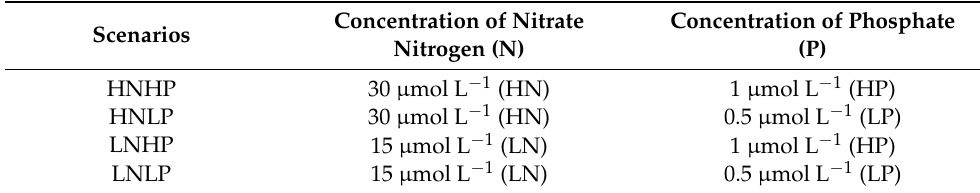
Table 1. Scenarios and nutrient concentration of experiments.